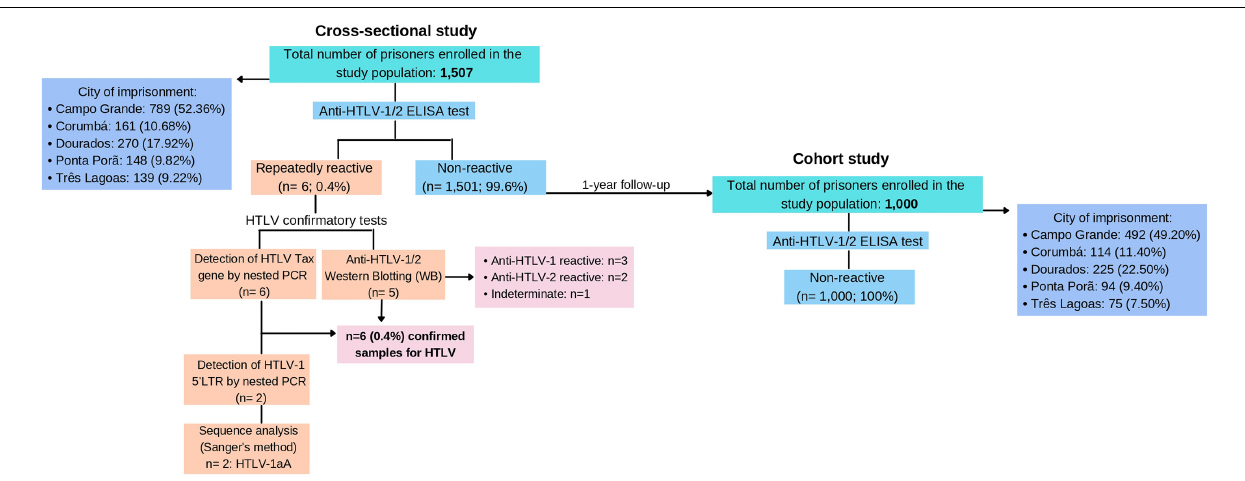
FIGURE 2 | Flow chart of the screening process for the detection of HTLV infection. Abbreviations: EPFCAJG – Estabelecimento Penal Feminino Carlos Alberto Jonas Giordano, EPC – Estabelecimento Penal de Corumbá, EPFIIZ – Estabelecimento Penal Feminino Irmã Irma Zorzi, CTAL – Centro de Triagem Anízio